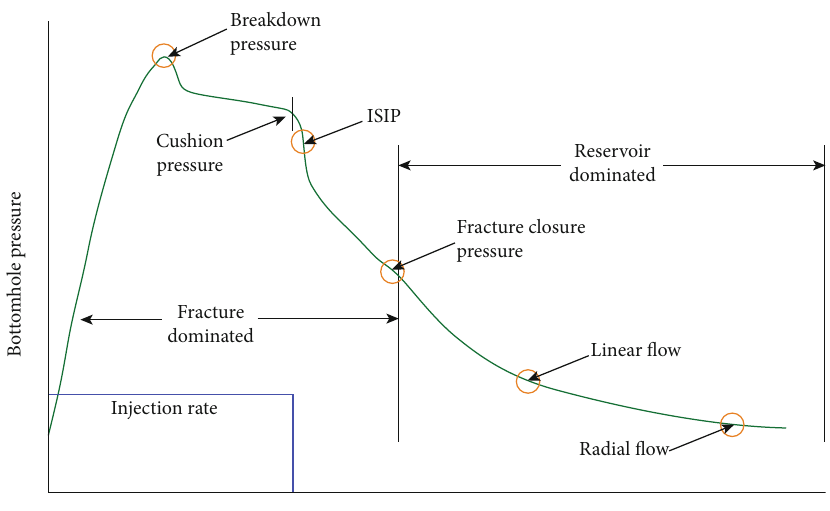
Figure 1: DFIT pressure response